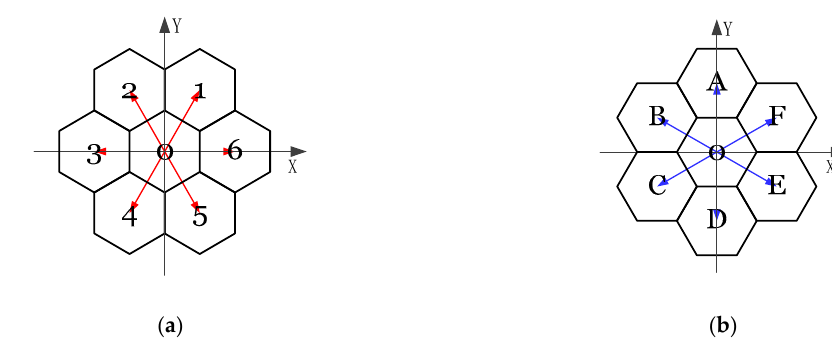
Figure 7. Two types of cell directions for the mixed aperture 3 and 4 hexagonal grids on the plane and the digits are marked for each basic vector of cell direction: ( a ) the first type of cell direction; ( b ) the second type of cell direction (source—own study).